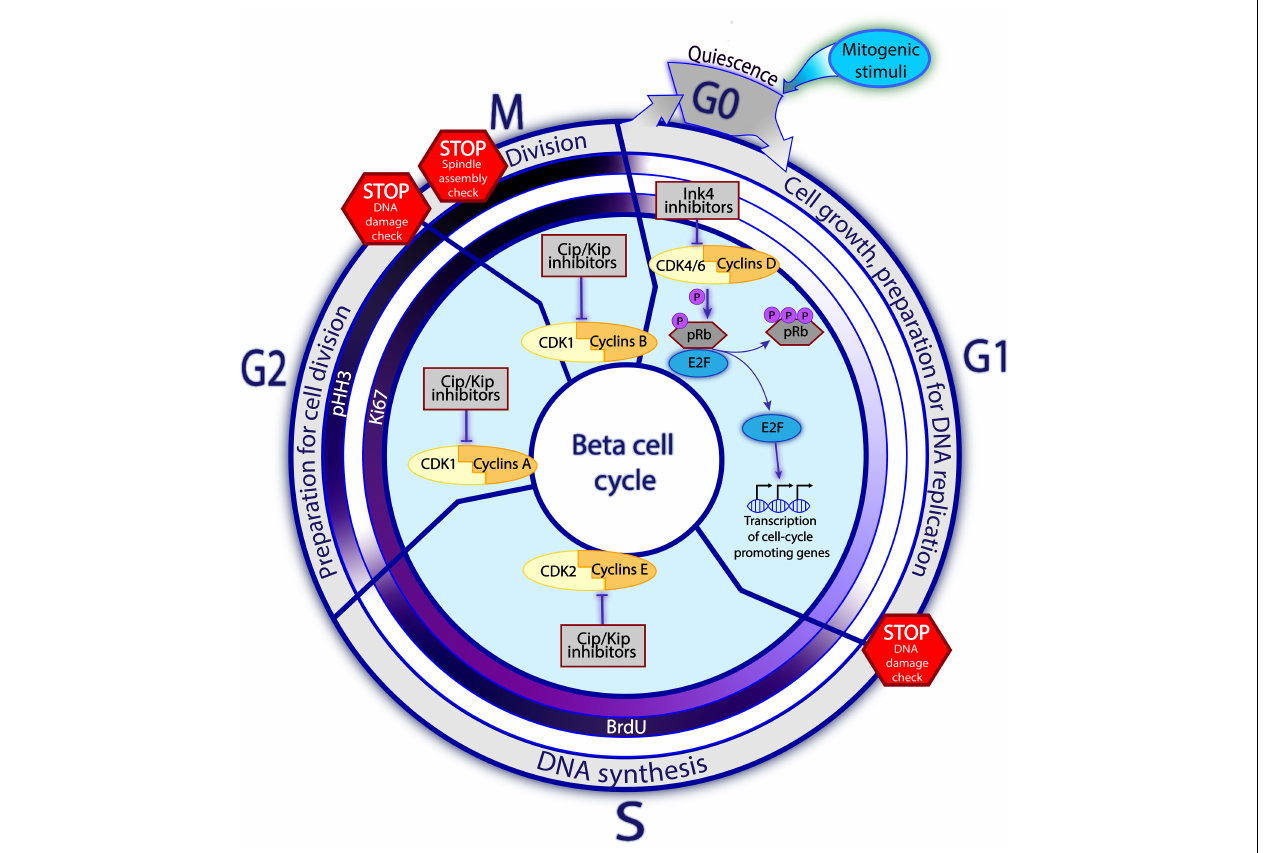
FIGURE 1 | Principles of cell cycle in the beta cell. Beta cells predominantly reside in a quiescent, non-mitotic G0 phase. Upon the mitogenic stimuli, the assembly of Cyclins D and CDK4/6 complex and consequent pRb inactivation via hyperphosphorylation trigger the cell cycle entry. Once the E2F transcription factors are released from the pRb restraining, they enhance expression of the cell cycle promoting genes, including the late Cyclins and CDKs. The activities of different Cyclins-CDK complexes gradually replace each other with the cell cycle progression, so that each Cyclins-CDK complex is dominant during different cell cycle phases. In G1, Cyclins D-CDK4/6 regulate cell growth and preparation for DNA replication. In the S phase, Cyclins E-CDK2 complexes control DNA replication. Whereas in phase G2, Cyclins A with CDK1 are driving preparation for the cell division. Finally, in phase M, complexes of Cyclins B-CDK1 regulate the cell division. The promoting activities of Cyclins-CDK complexes are negatively regulated by the cell cycle inhibitors. Families of Ink4 and Cip/Kip inhibitors restrain the early and late Cyclins-CDKs complexes, respectively. On the way towards division, the cell must encounter several STOP checkpoints whereby the cell state, DNA integrity and the surrounding conditions are checked. Cells which do not pass the checkpoint, are blocked from cell cycle progression until the conditions improve or, in an irresolvable situation, undergo apoptosis. The inner circles on Figure 1 represent the commonly used proliferation markers: Ki67, BrdU, pHH3. Intensity of the violet color corresponds to the abundance of the marker at a given phase, with white color indicating absence of the marker and dark violet – the highest